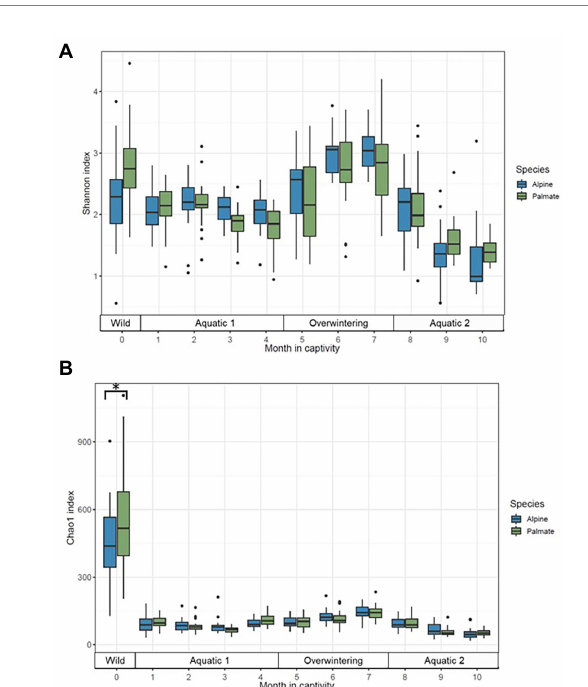
FIGURE 3 Alpha diversity of the skin microbiota of alpine (blue) and palmate (green) newts, across time of the experiment, measured as Shannon (A) and Chao1 (B) indices. Box plots represent median (horizontal line), 25th and 75th percentile (box), 5th and 95th percentile (whiskers). Dots show individual outlier values of alpha diversity. The bracket with the asterisk indicates a significant difference in diversity between wild species.